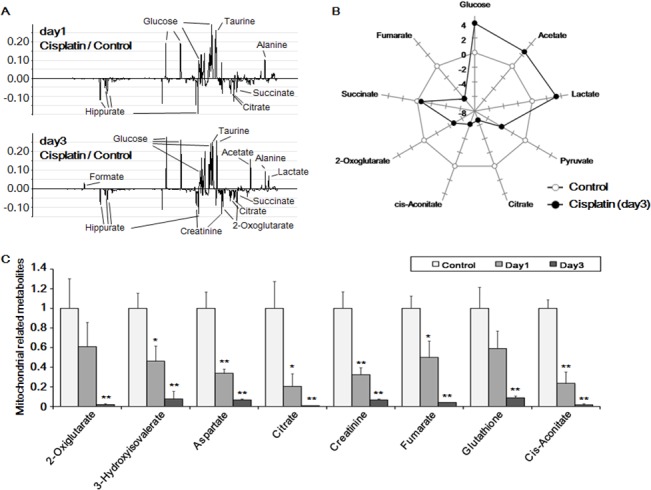
Metabolite profiling of cisplatin-treated rat urine samples.(A) Proton nuclear magnetic resonance (1H-NMR) spectra of day 1 (upper) and day 3 (lower) after cisplatin injection compared with those of controls. (B) Alterations of glycolysis- and tricarboxylic acid (TCA) cycle-related metabolites compared with control samples. (C) Effect of cisplatin on the level of mitochondria-related metabolites in urine samples. The mean ± S.D. of three independent experiments are presented; *p < 0.05, **p < 0.01, by paired t-test.